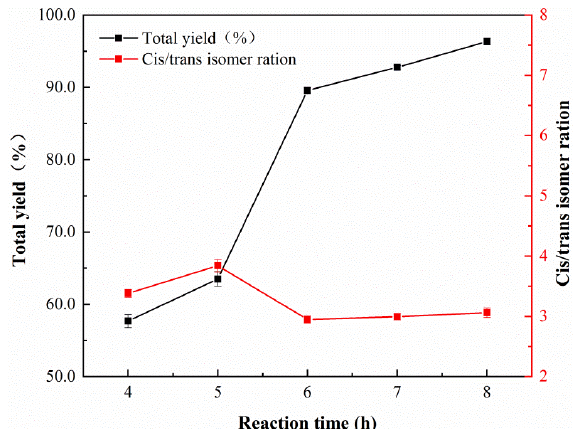
Figure 8. Effect of reaction time on nano-Fe/Pd catalytic activity in the reaction. Reaction conditions: catalyst (10 mg), acetylene (11 mmol), MeOH (20 mL), KI (112 mg), P CO = 1.8 MPa, P total = 4.0 MPa, T = 323.2 K.